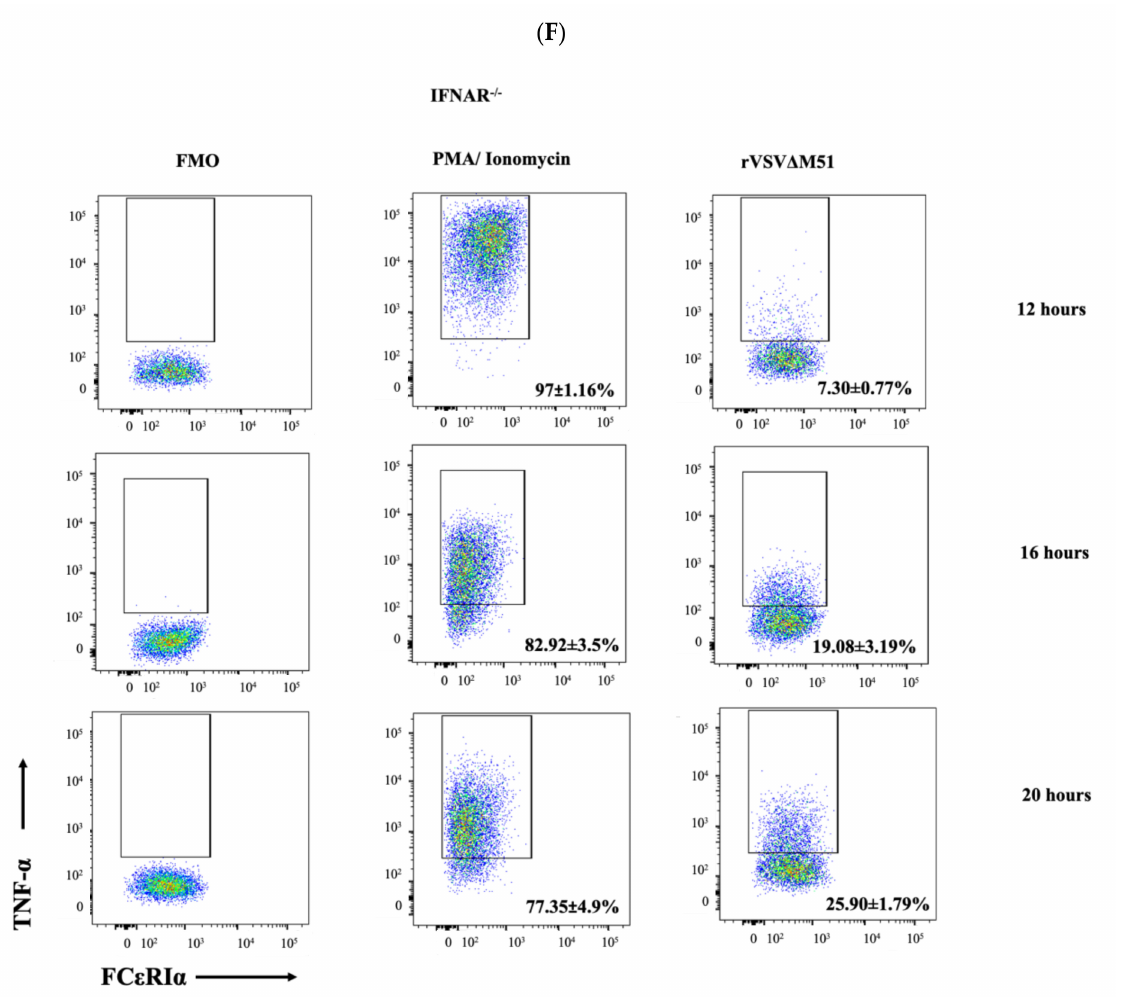
Figure 5. Recombinant vesicular stomatitis virus (rVSV ∆ m51)-induced cytokine production by murine bone-marrow-derived mast cells (BMMCs) was regulated by type I interferon receptor (IFNAR) signaling. BMMCs that were left untreated (intact BMMCs) or incubated with an antibody that blocked IFNARs (IFNAR-blocked BMMCs) or derived from IFNAR-knockout mice (IFNAR − / − BMMCs) were infected with rVSV ∆ m51 at a multiplicity of infection of 10. After 12, 16, and 20 h, the cells were stained for the surface markers Fc ε RI α and c-kit, as well as intracellular cytokines interleukin (IL)-6 and tumor necrosis factor (TNF)- α . The cells were then analyzed by flow cytometry, and fluorescence minus one (FMO) controls were used to set gates to identify IL-6 + and TNF- α + BMMCs. Expression of ( A ) IL-6 and ( B ) TNF- α expression in Fc ε RI α + c-Kit + mast cells is shown after infection with rVSV ∆ m51 or treatment with phorbol 12-myristate 13-acetate (PMA) and ionomycin as a positive control stimulus. Graphs show means and standard deviations pooled from four (IFNAR-intact and -blocked BMMCs) or six (IFNAR − / − BMMCs) experimental replicates. Two-way analysis of variance with Tukey’s multiple comparison test was used to define statistical significance as ** p < 0.001; *** p < 0.0005; **** p < 0.0001. Representative dot plots of ( C ) IL-6 expression in IFNAR-blocked and ( D ) IFNAR − / − BMMCs as well as TNF- α expression in ( E ) IFNAR-blocked and ( F ) IFNAR − / − BMMCs are